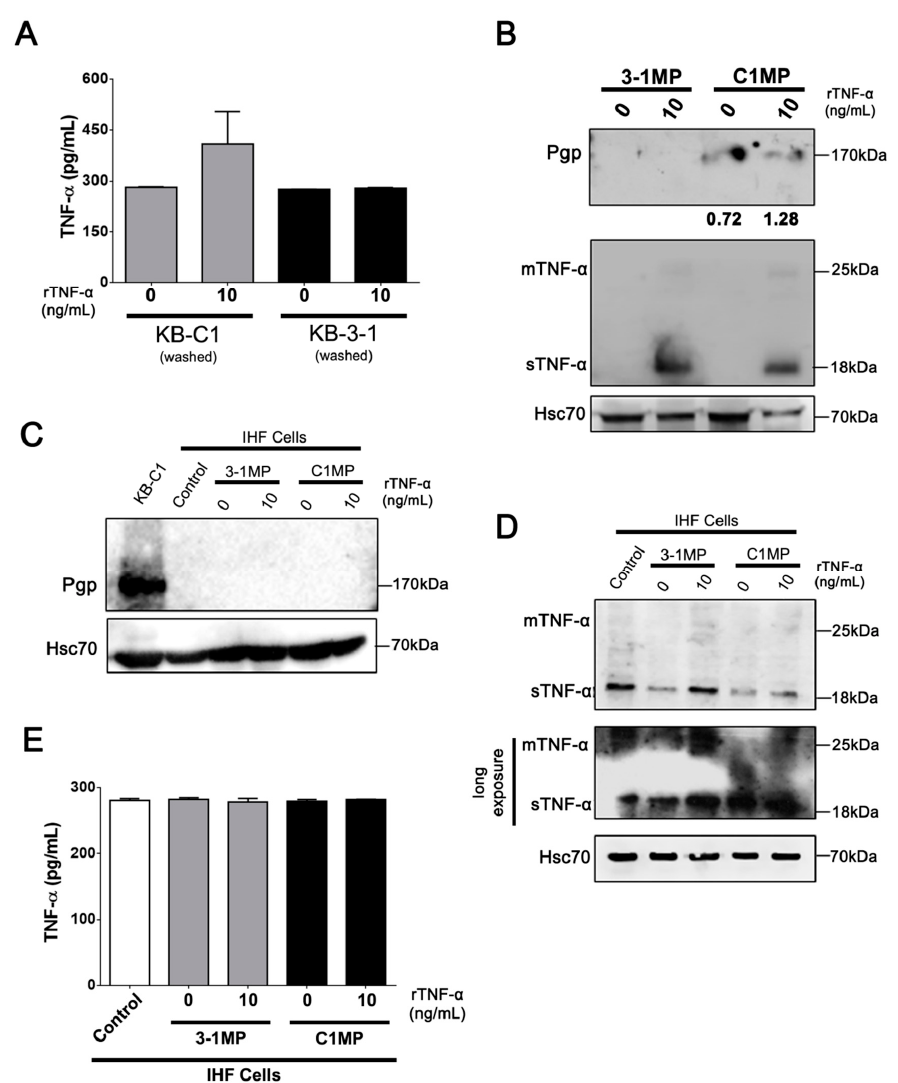
Figure 5. Analysis of microparticles (MP) content derived from parental and MDR cells and its e ff ects in the IHF cell line. ( A ) Comparison of soluble TNF- α secretion in supernatant of KB-3-1 and KB-C1 cells treated for 24 h with 10 ng / mL rTNF- α , determined by ELISA. ( B ) Immunoblot analysis of Pgp and endogenous TNF- α protein levels in 3-1MP and C1MP derived from non-treated or 10ng / mL rTNF- α treated cells. Western blot bands were quantified by densitometry. Immunoblot analysis of ( C ) Pgp and ( D ) TNF- α protein levels in IHF cells after 24 h of incubation with 3-1MP or C1MP derived from non-treated or 10 ng / mL rTNF- α treated cells. ( E ) Comparison of soluble TNF- α liberation in supernatant of IHF cells treated for 24 h with 3-1MP or C1MP derived from non-treated or 10 ng / mL rTNF- α treated cells, determined by ELISA. Data are means ± SD of two independent experiments. One-way ANOVA with Dunn’s posttest post were used to analyze the ELISA